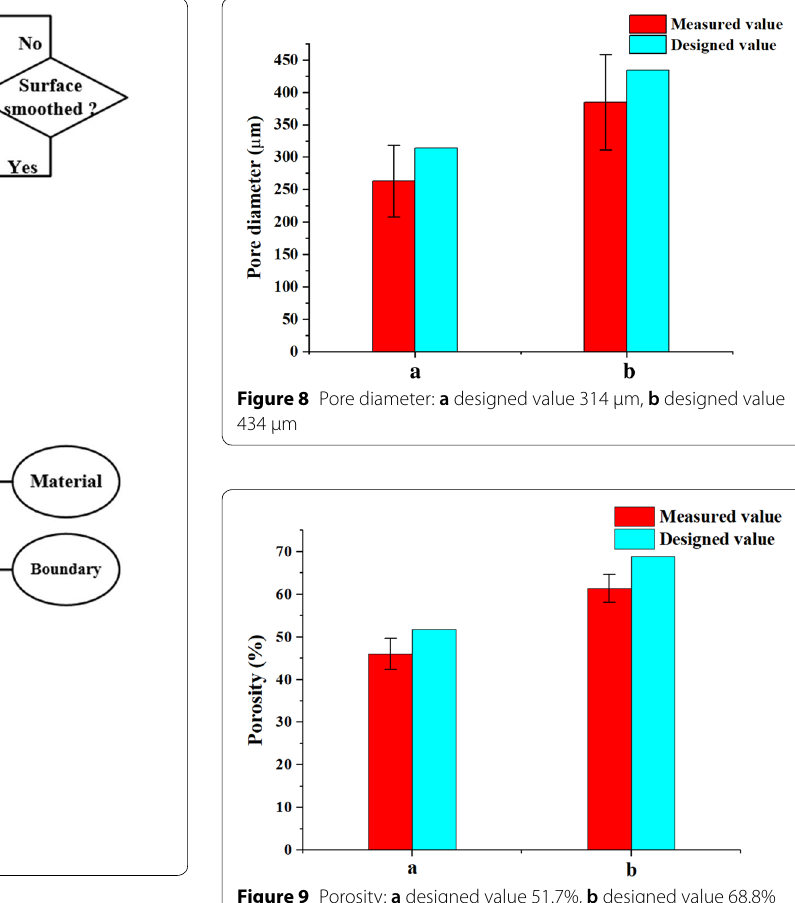
Figure 9 Porosity: a designed value 51.7%, b designed value